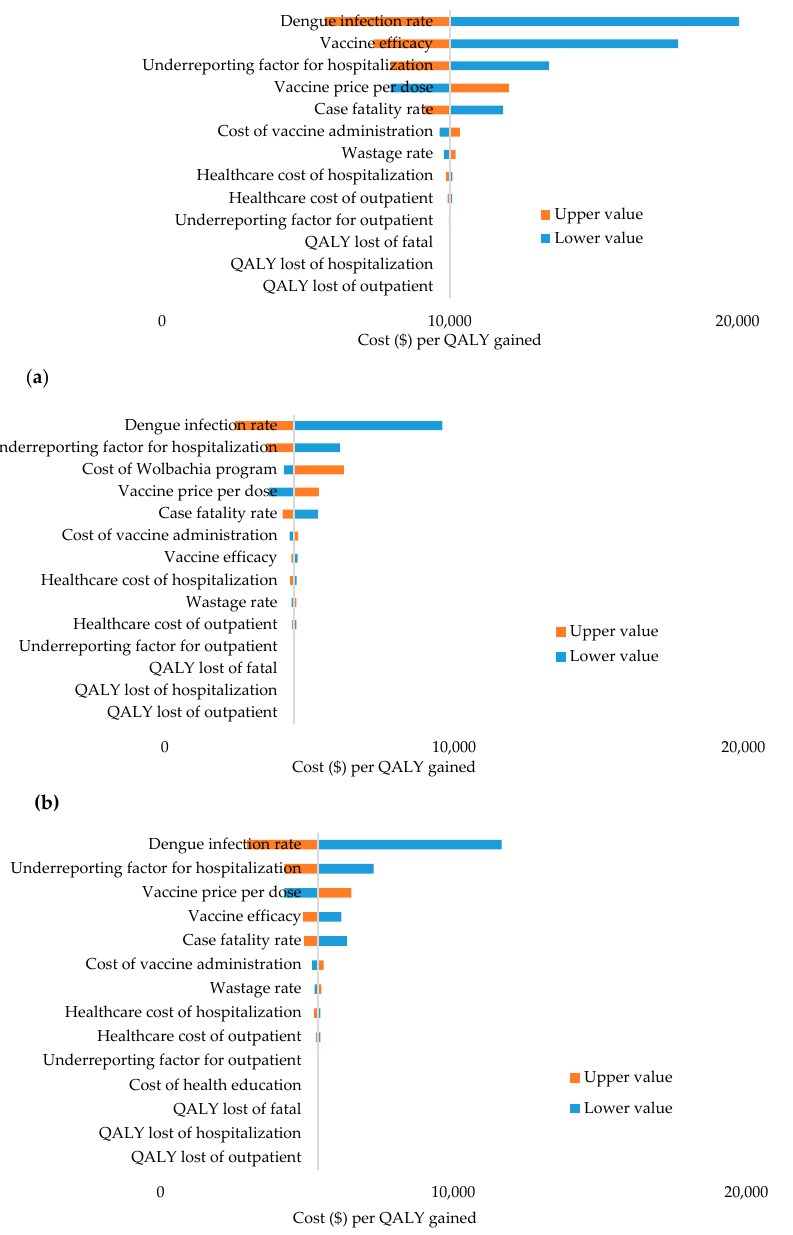
Figure 5. ( a ) Univariate sensitivity analysis (vaccination only); ( b ) Univariate sensitivity analysis (vaccination + Wolbachia program); ( c ) Univariate sensitivity analysis (vaccination + health education). Applying a threshold ICER of $4,460 (ICER in vaccination combined with a Wolbachia program),